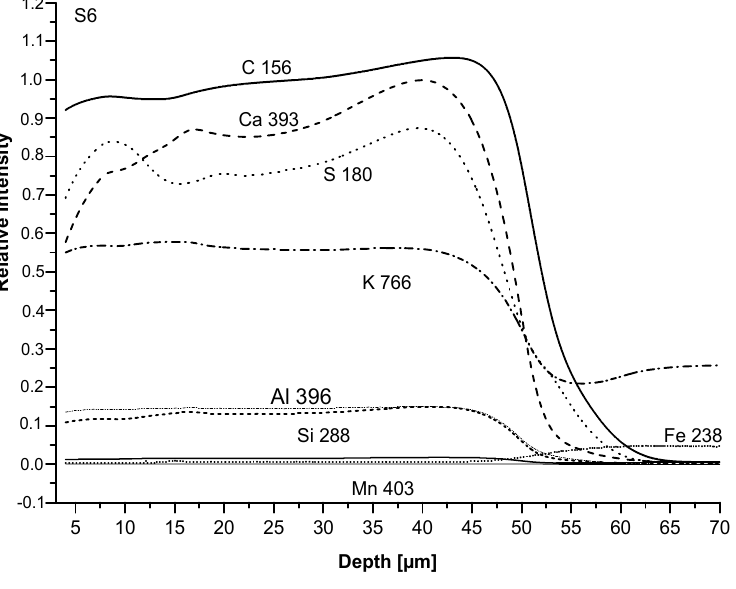
Figure 10. GDOES of the S6 sample.